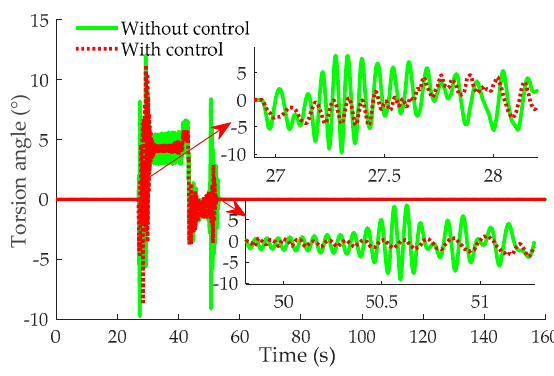
Figure 20. Torsional damper angle.